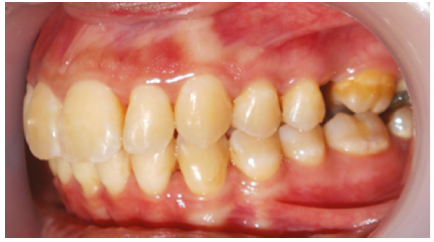
Figure 7: Final left side view 2 years post treatment.